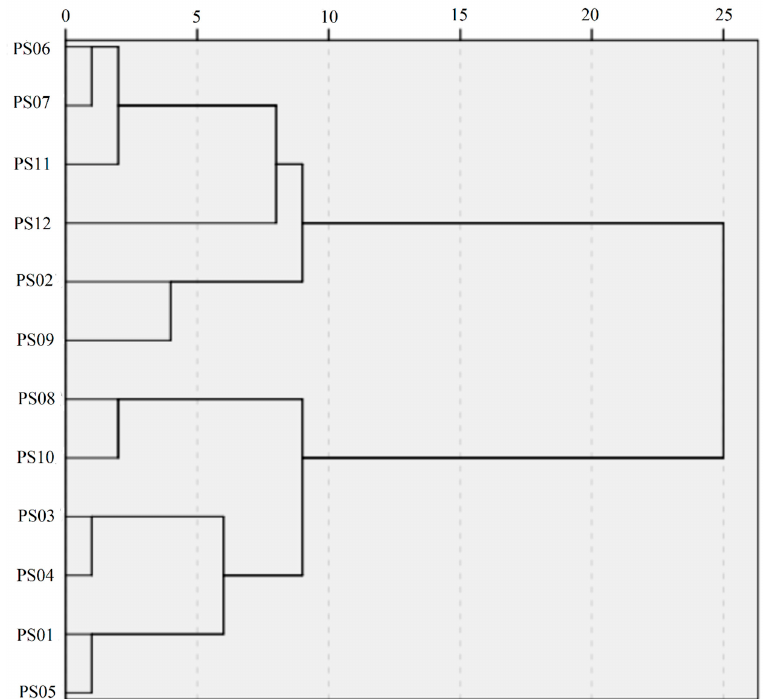
Figure 5. Cluster analysis of the 12 batches of SMB samples.